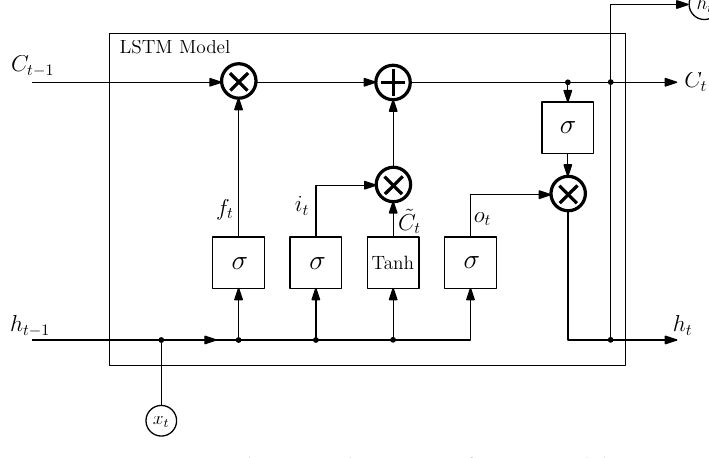
Figure 1. The internal structure of LSTM